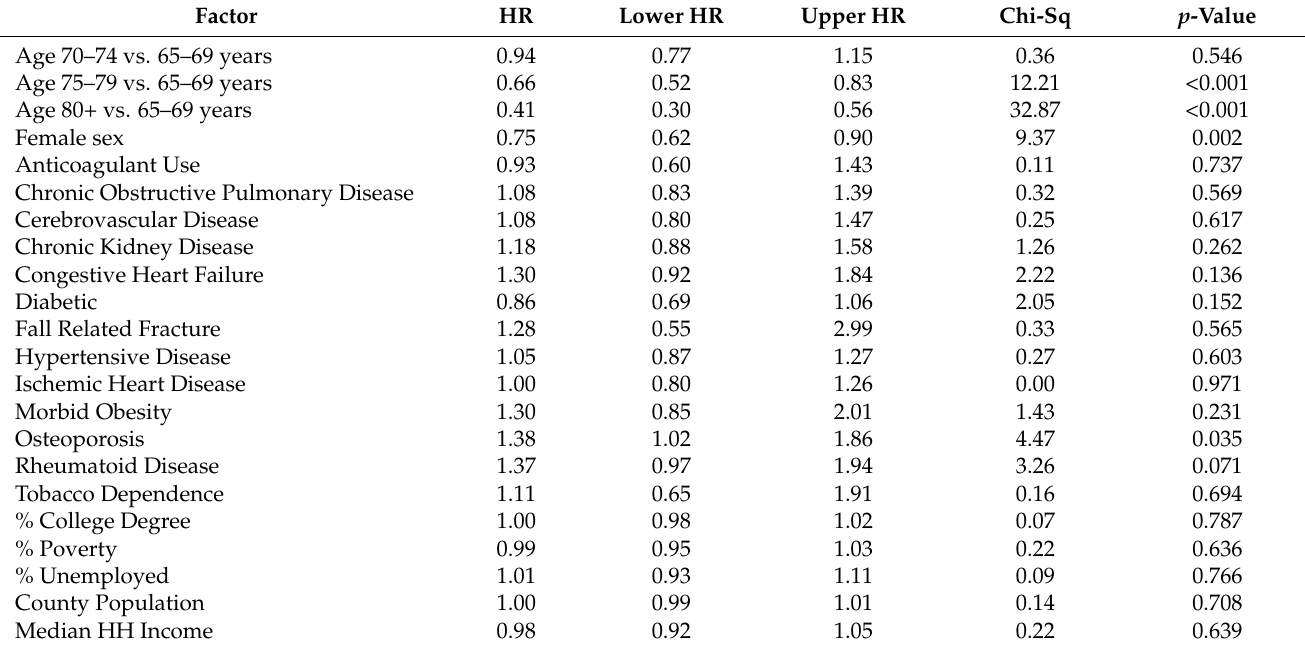
Figure 2. Revision rates after shoulder arthroplasty for proximal humerus fracture. The unrevised fraction of patients undergoing hemiarthroplasty is shown in red, and the unrevised fraction of patients undergoing total shoulder arthroplasty is illustrated in blue. Table 2. Multivariate analysis of risk factors for revision surgery after shoulder arthroplasty. HR = hazard